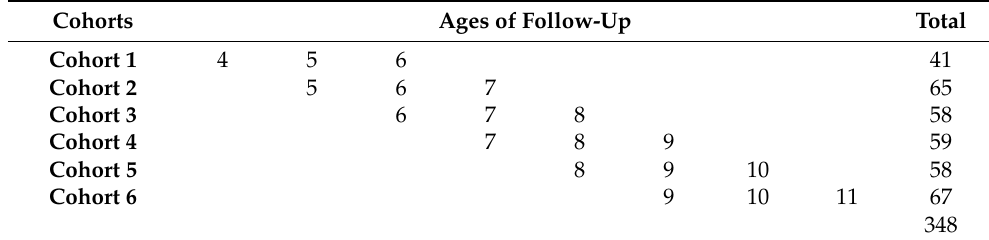
Table 1. Number of children per cohort and age